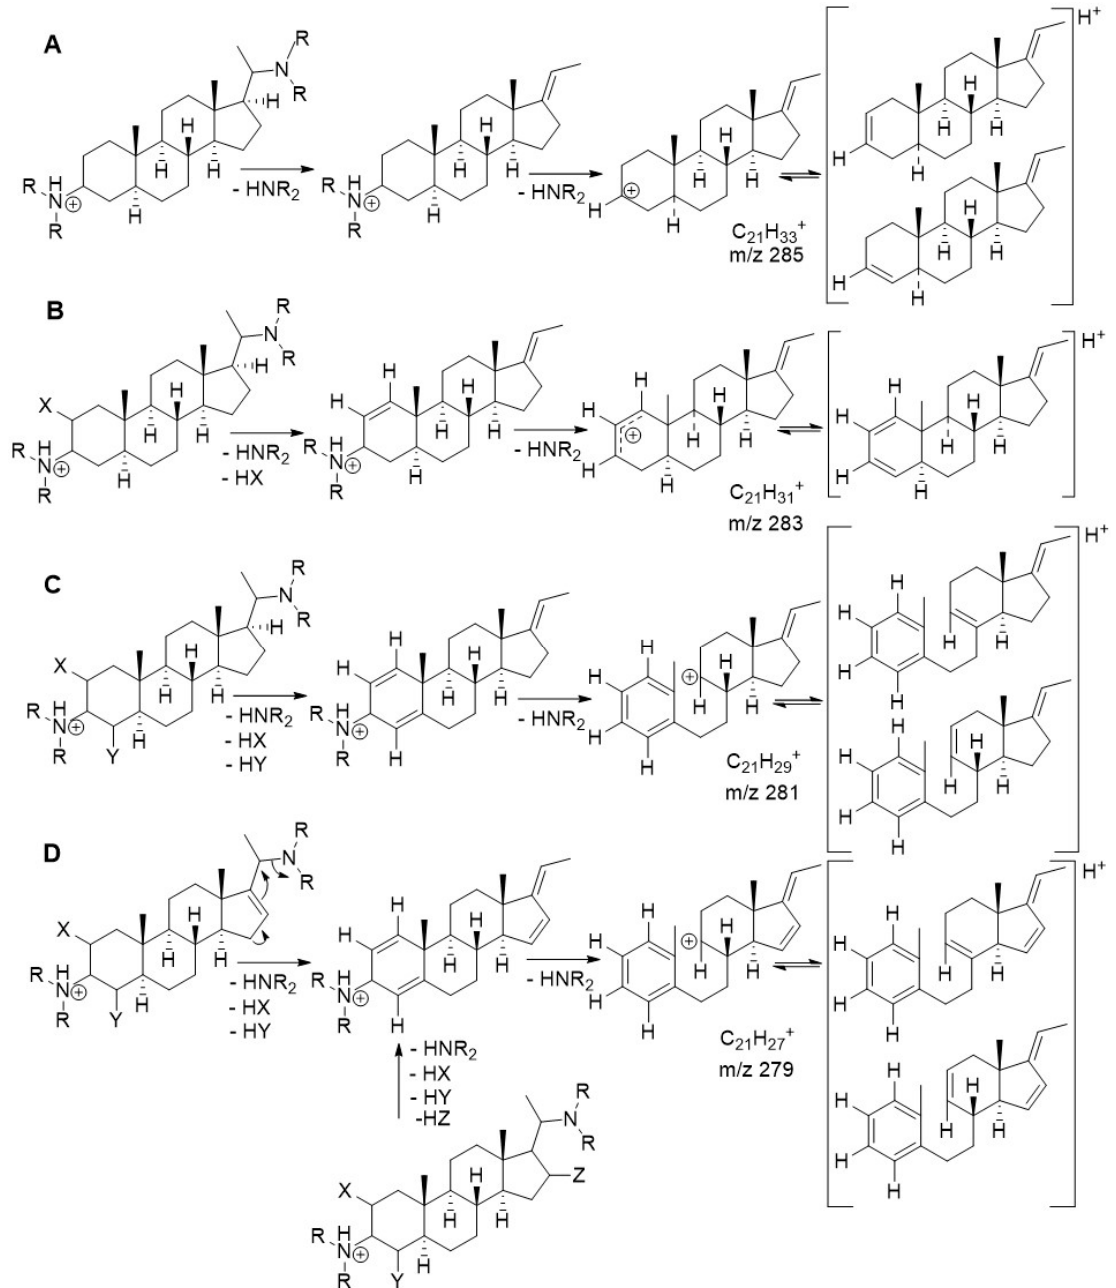
Figure 4. +ESI MS fragmentation pathways of amino-/amidosteroids depending on the substitution-/unsaturation pattern in the steroid core. ( A ) fully saturated and further unsubstituted C-3-/C-20 diamine or diamides: core fragment (CF) at m/z 285; ( B ) singly substituted or unsaturated: CF at m/z 283; ( C ) double substituted or unsaturated: CF at m/z 281; ( D ) double substituted with additional unsaturation or triple substituted: CF at m/z 279, according to Musharraf et al. [9] (modified). The previous authors formulated the system resulting from the loss of the C-20 substituent as a vinyl group (double bond from C-20 to C-21). In the course of the present study, quantum mechanical calculations were carried out which show that the ethylidene group formulated here is energetically much more favorable (see Section 2.4). Furthermore, bond breaking between C-4 and C-5 under formation of a double bond between C-3 and C-4 and localization of the positive charge at C-5 as well as breaking between C-9 and C-10 under formation of a C-10=C-1 ‒ C-2=C-3 diene with the positive charge at C-9 were postulated for cases A and B upon elimination of the C-3-amino- or amido substituent [9]. In the course of this study, quantum mechanical calculations indicated that a bond breaking (between C-9 and C-10) is predicted by theory only in cases C and D, where this can lead to an aromatic system (see Section 2.4).